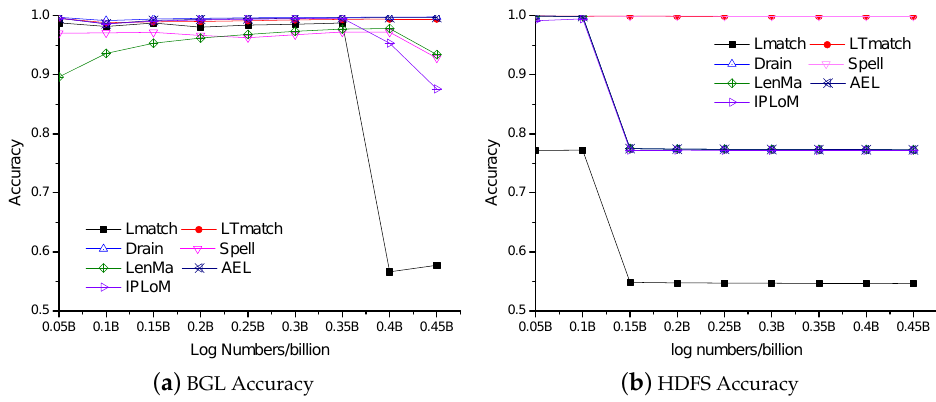
Figure 4. Accuracy of different log parsers over different sizes of BGL/HDFS log data